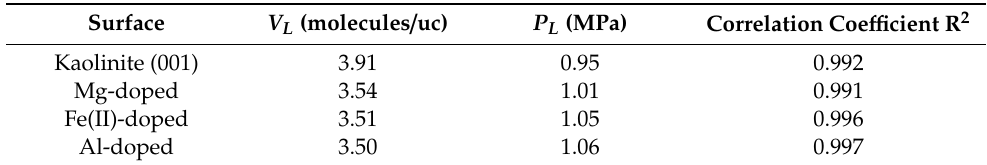
Table 1. Langmuir constants obtained by fitting the Langmuir model to the absolute adsorption amount of CH 4 on pure and Mg-, Fe(II)-, and Al-doped kaolinite at 293.15